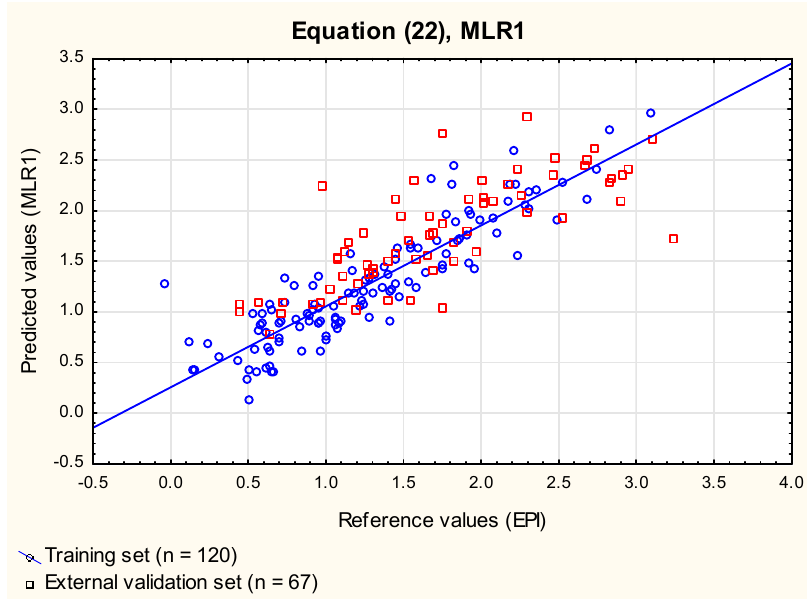
Figure 1. MLR1 model, Equation (22)—predicted vs. reference log BCF values.